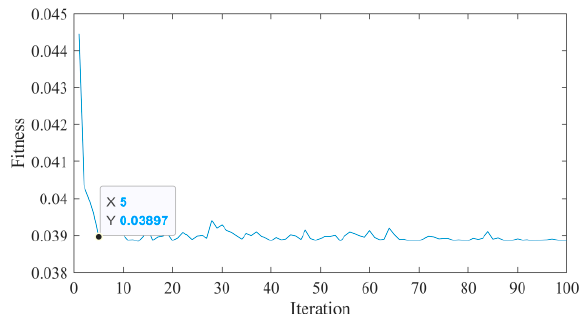
Figure 8. Fitness optimization curve.